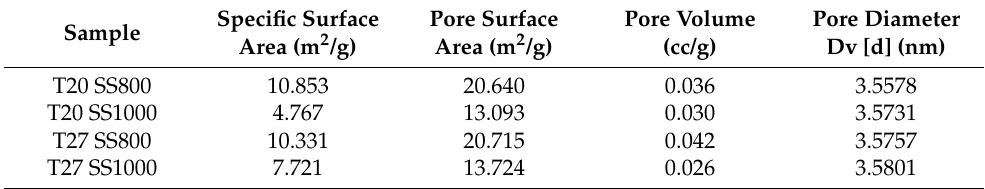
Table 6. Effect of temperature (20 ◦ C, 27 ◦ C) and stirring speed (800 rpm, 1000 rpm) on the